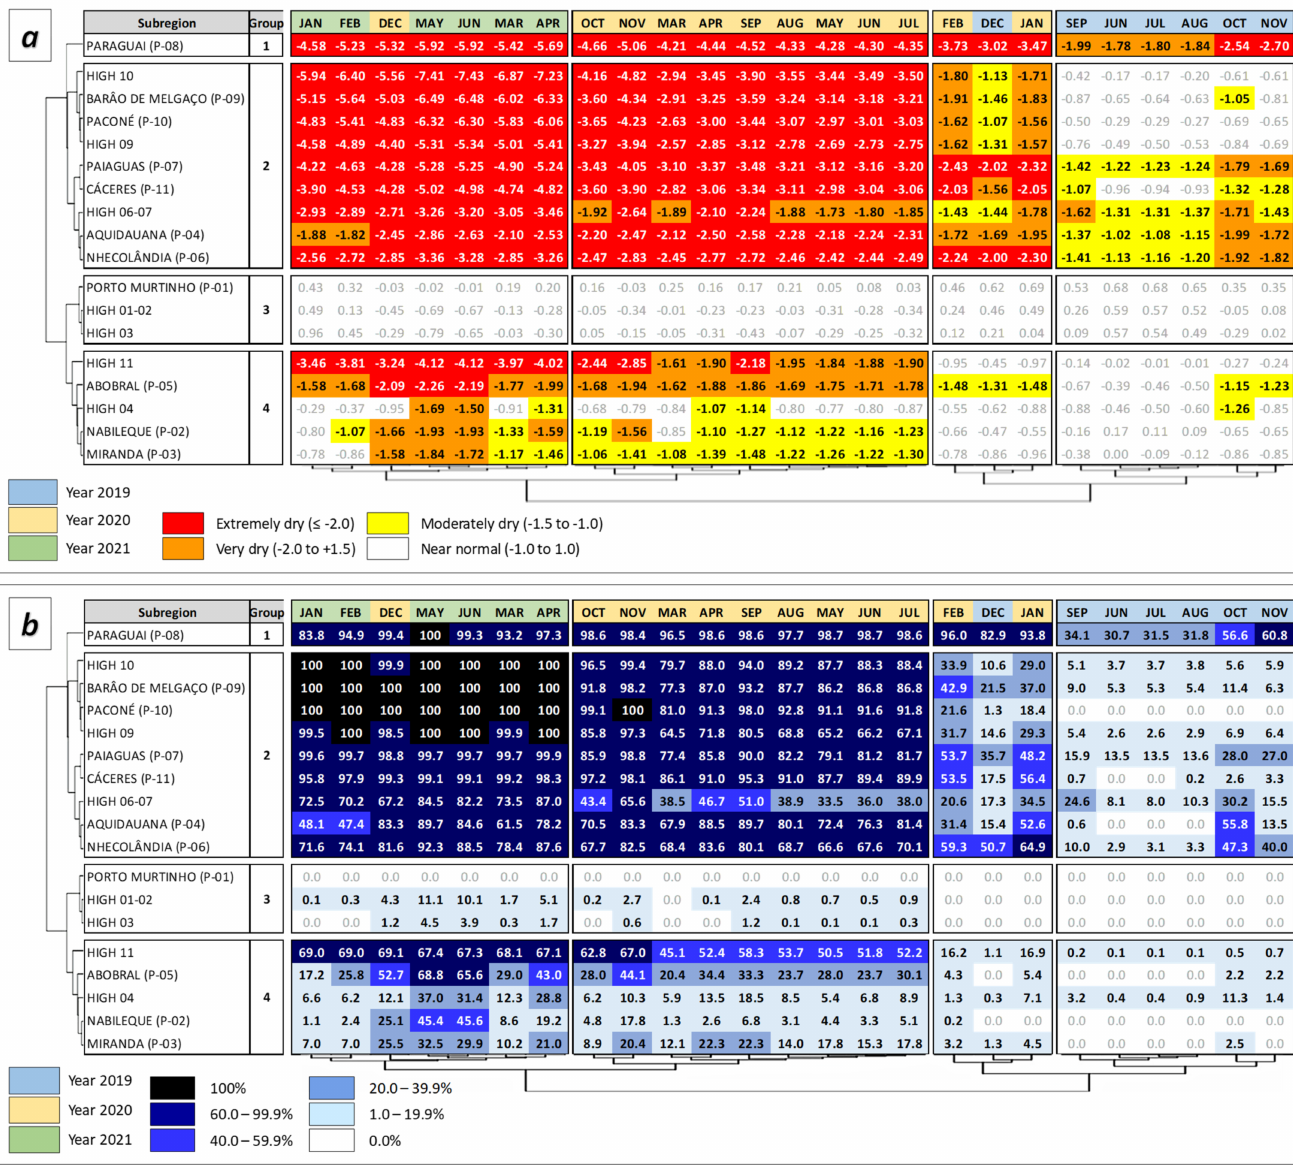
Figure 7. ( a ) Monthly mean Standardized Precipitation Drought Index (SPDI) dynamics from June 2019 to June 2021 at the different sub-regions of the Pantanal and the surrounding Highlands. ( b ) Relative area of aforementioned sub-regions with an extreme drought condition (SPDI ≤ − 2.0). Sub-regions were taken from Thielen et al. [13]. Cluster analysis (K-means clustering using Euclidean distance) was performed to both rows and columns, and with the statistical tool ClustVis